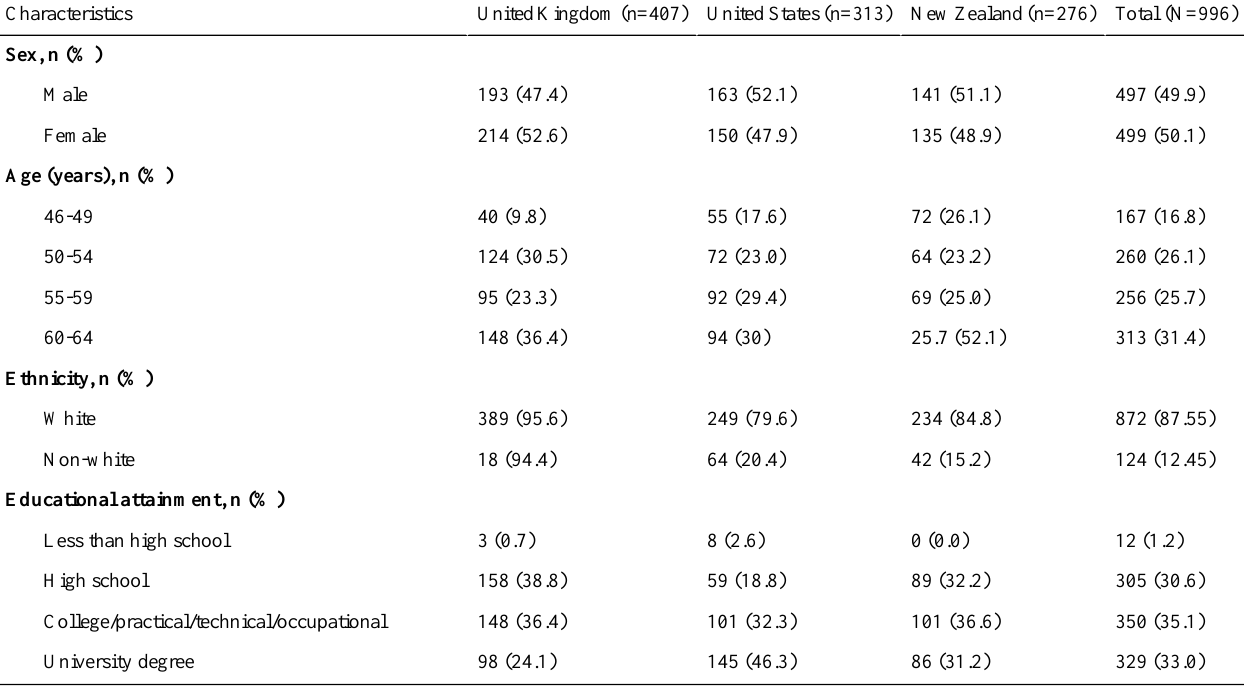
Table 2. Sample characteristics by country